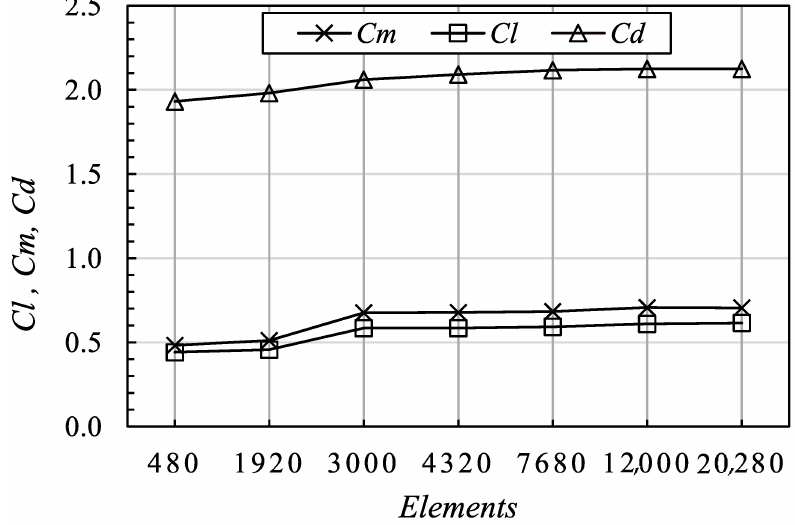
Figure 4. The variation of hydrodynamic coefficients with the mesh size.